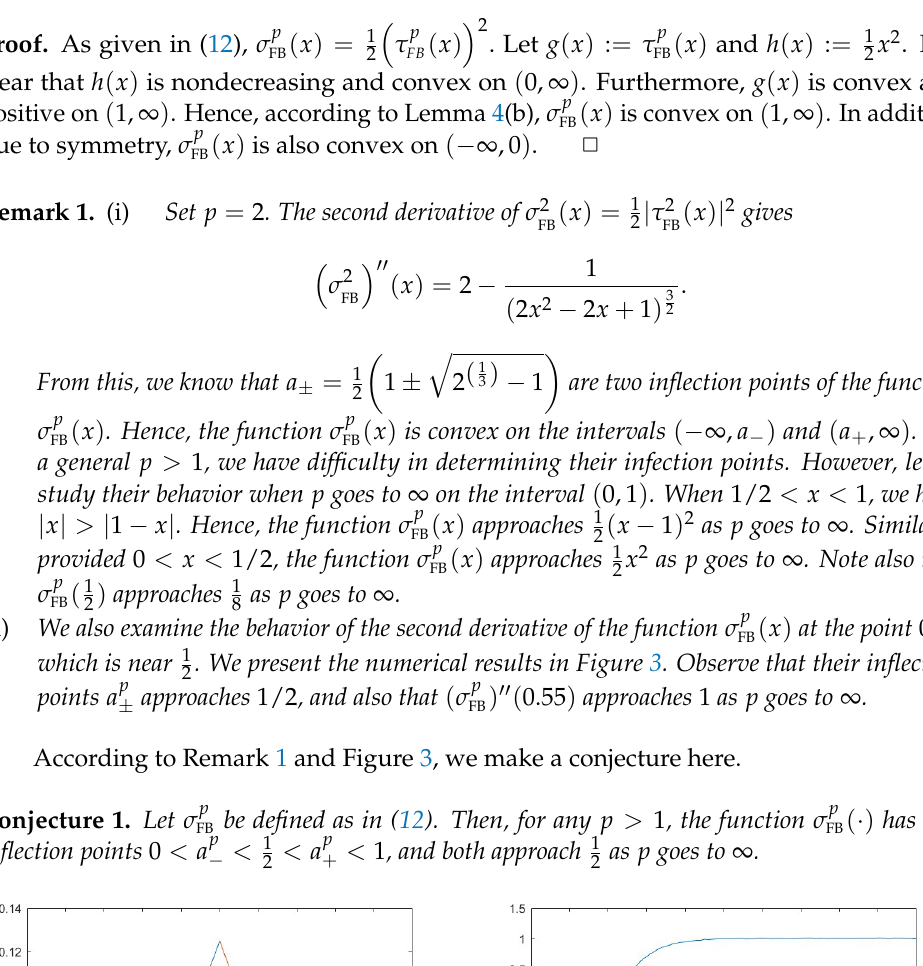
Figure 3. Graphic evidence regarding Remark 1 and Conjecture 1. ( a ) Graphs of σ ∞ 0 < x < 1; ( b ) Graphs of ( σ p